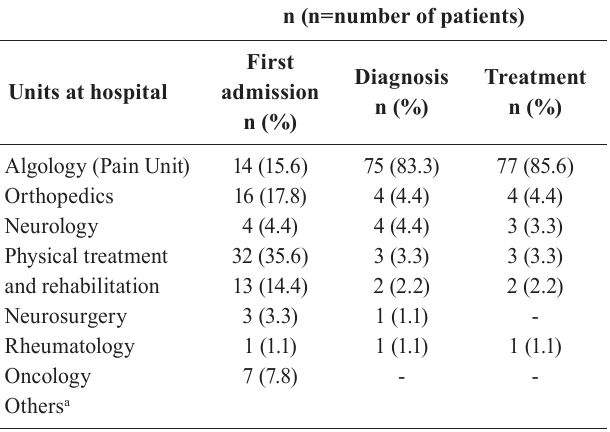
TABLE III - Utilized health units for diagnosis and treatment of neuropathic